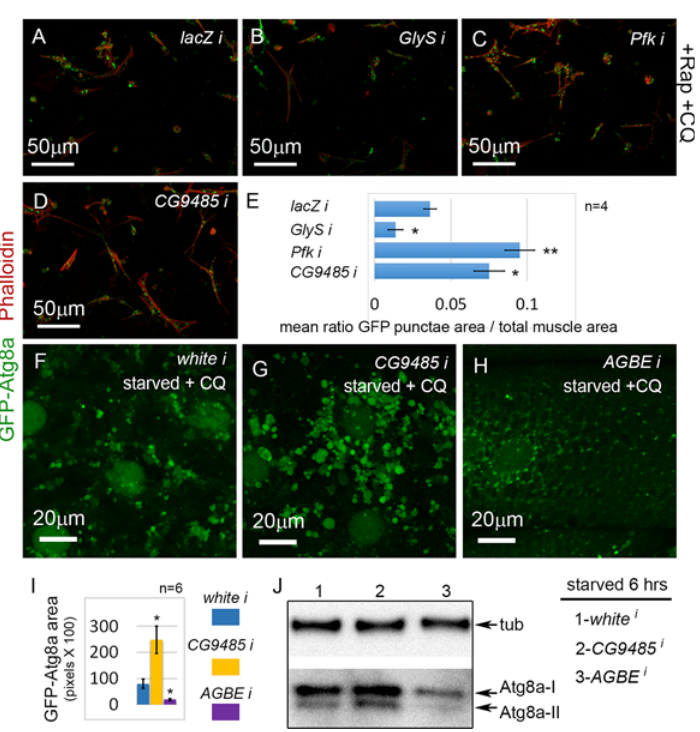
Fig 7. Glycogen metabolism enzymes are autophagy regulators in skeletal muscle. (A) Primary cultured muscles with control lacZ RNAi, treated for 12 hrs with Rap+CQ. Note the formation of large GFP- Atg8a vesicles throughout the muscles. (B) GFP-Atg8a vesicles are reduced in primary cultured muscles with GlyS RNAi, treated for 12 hrs with Rap+CQ. Knockdown of Pfk (C) or CG9485 (D) causes increased accumulation of GFP-Atg8a vesicles in primary cultured muscles treated for 12 hrs with Rap+CQ. ( E) Quantification for A-D of the mean ratio of GFP-Atg8a punctae area to total muscle area per well (n = 4). SEM is indicated with * p < .05; ** p < .01. (F-H) Dmef2-Gal4 drives expression of UAS-GFP-Atg8a in animals starved on low nutrient food + 1 mg/ml CQ for 6 hrs. (F) Control white RNAi muscles accumulate large autophagosomes at 1 mg/ml CQ. (G) RNAi knockdown of CG9485 increases autophagosome accumulation in the muscle. (H) RNAi knockdown of AGBE reduces autophagic vesicle accumulation in the muscle. (I) Quantification of the GFP-Atg8a punctae area in muscles from white , CG9485 , and AGBE knockdowns. n = 6 larval muscles with SEM indicated and * p < .05. In all panels green = GFP-Atg8a and red = Phalloidin. (J) Western blot analysis of endogenous Atg8a from third instar muscle lysate. Dmef2-Gal4 driven knockdown of AGBE but not CG9485 inhibits Atg8a lipidation, indicating reduced autophagy